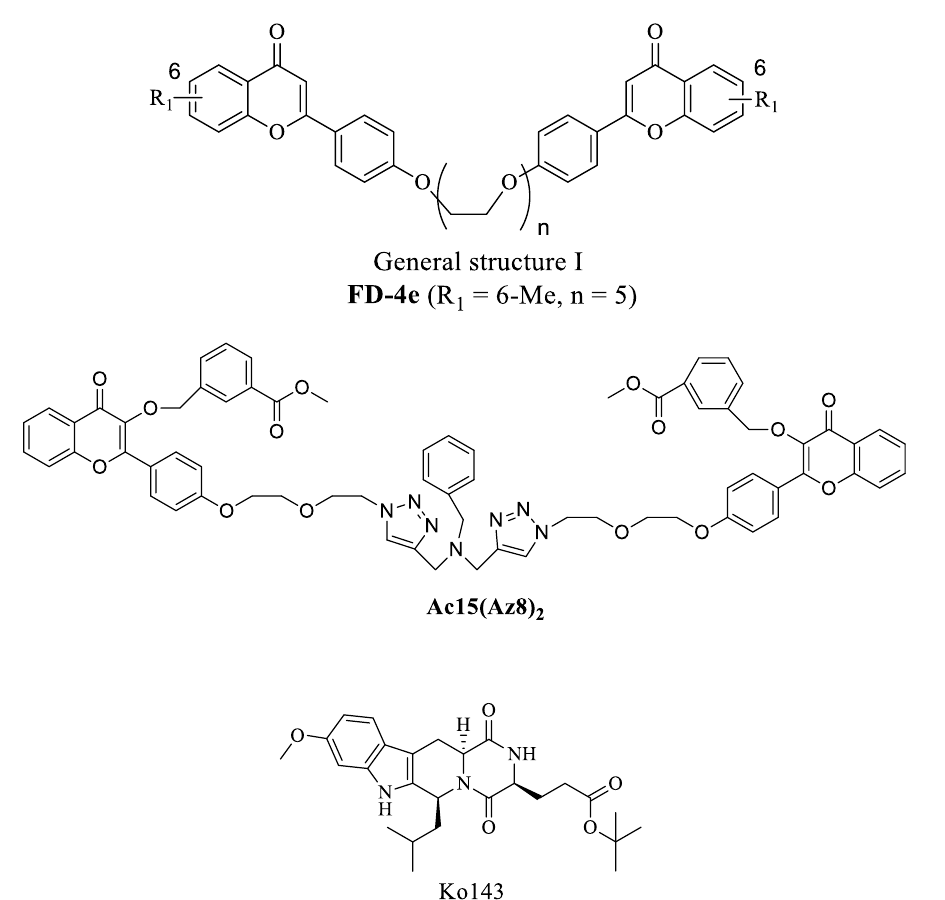
Figure 1. Chemical structure of general structure I, Ac15(Az8) 2 and Ko143.